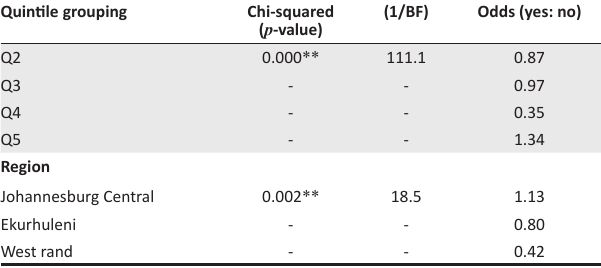
TABLE 5: Tests of association of various categorical variables for association to bullying. Quintile